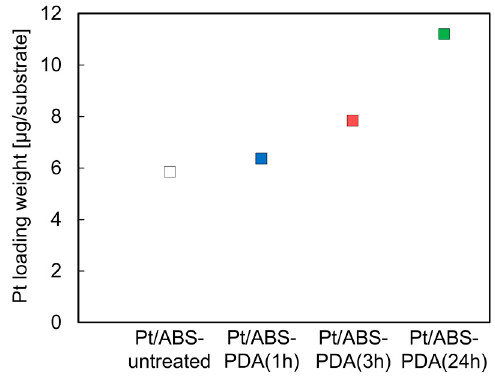
Figure 5. Pt-loading weights of Pt / ABS samples with or without the PDA coating.